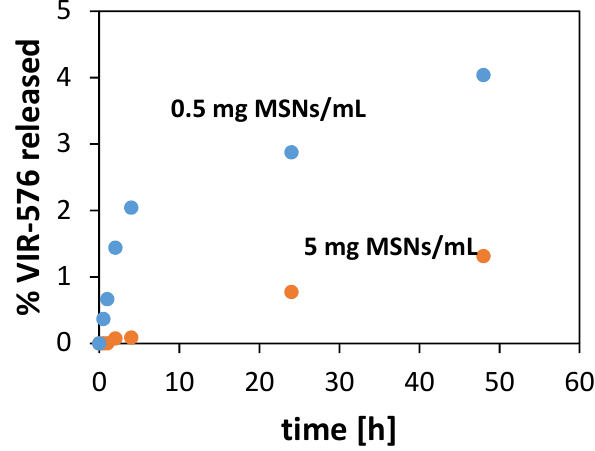
Figure 3. Release of VIR-576 into PBS buffer from MSNs having an initial VIR-576 loading of 11.5 wt % as a function of particle concentration. T = 25 °C. Error = ± 0.2%-units.